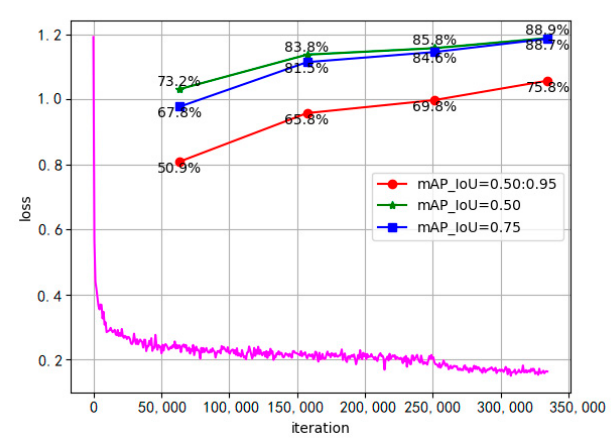
Figure 6. The PVformer training process and loss changes.